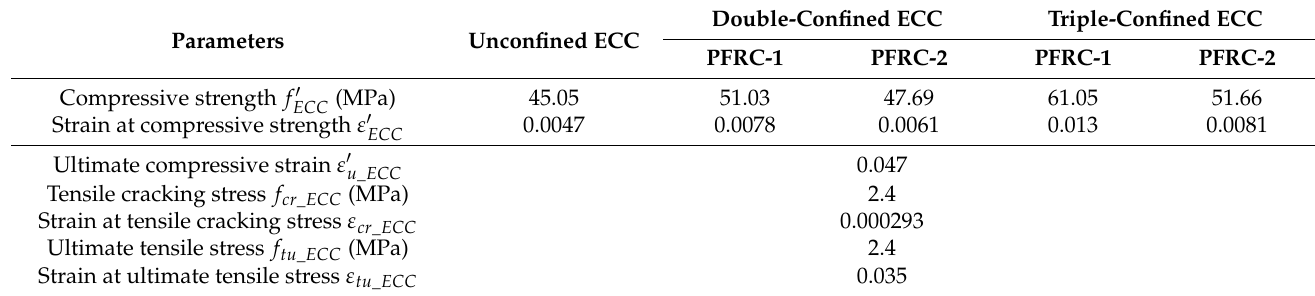
Figure 8. Material model. ( a ) Constitutive model for ECC, ( b ) Constitutive model for longitudinal bar. Table 3. Parameters in unconfined and confined ECC